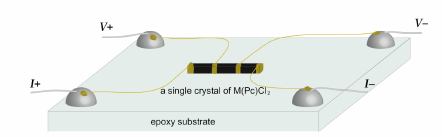
Figure 4. Schematic of the electrical resistivity measurements. Four or two gold wires were attached to a single crystal using gold paste.